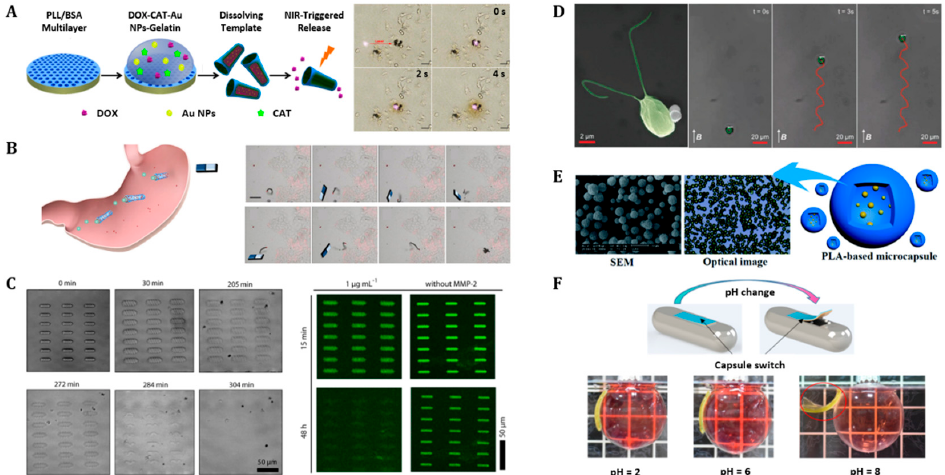
Figure 4. Biodegradable drug delivery carriers. ( A ) Fabrication and light-triggered drug release process of biodegradable (PLL/BSA)10-DOX-CAT-AuNPs-gelatin-based drug delivery rockets. Reproduced with permission [58]. Copyright 2015, The American Chemical Society. ( B ) Magnetic guidance of a single DOX/PASP/Fe-Zn MR in vitro for effective localization in the stomach. Reproduced with permission [90]. Copyright 2019, The American Chemical Society. ( C ) Microscale biodegradable swimmer array in the presence of an enzyme for drug release. Reproduced with permission [65]. Copyright 2019, The American Chemical Society. ( D ) Algal (Chlamydomonas reinhardtii ) micro-swimmer’s propulsion trajectories under 26 mT of uniform magnetic field. Reproduced with permission [136]. Copyright 2018, Wiley-VCH. ( E ) SEM and optical images of a PLA-based microcapsule (left) and schematic image of the microcapsule (right). Reproduced with permission [75]. Copyright 2017, The Royal Society of Chemistry. ( F ) Actuator-controlled drug release model fabricated with a polyacrylic acid (PAAc) and polyacrylamide (PAAm) bilayer (left), and the PAAcPAAm bilayer soaked in different aqueous solutions of pH 2, 6, and 8 (right). Reproduced with permission [93]. Copyright 2017, The Royal Society of